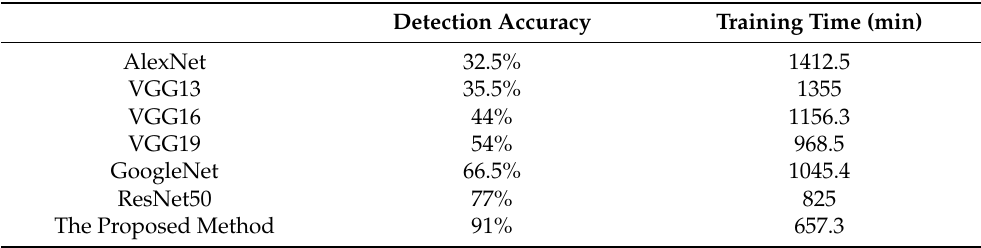
Table 4. The comparison results between the proposed model and the current popular detection